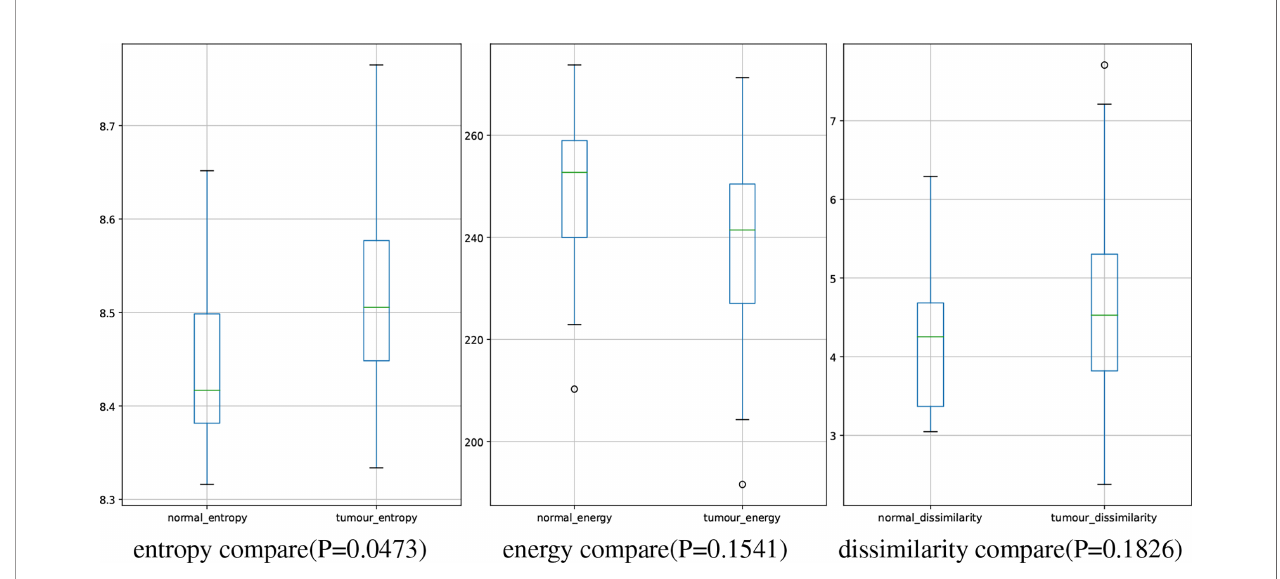
FIGURE 9 | Boxplot of numerical distributions with different